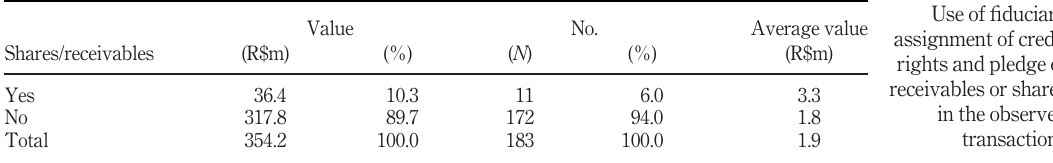
Table VI. Use of fi